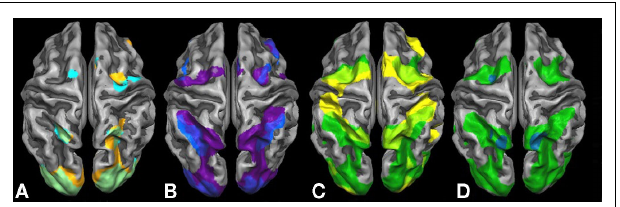
FIGURE 2 | Brain activation contrasts against rest for all six tasks projected onto aTalairach child template. Brain activations significant at a cluster-threshold corrected p -value of 0.05 are depicted: (A) symbolic (light blue) and non-symbolic (light orange) magnitude comparison; (B) symbolic (dark blue) and non-symbolic (purple) exact addition; (C) visually guided finger movements (yellow) and visually guided saccades (dark green); and (D) visually guided saccades/encoding phase (dark green) and sustained activity phase (turquoise) of the visual working memory